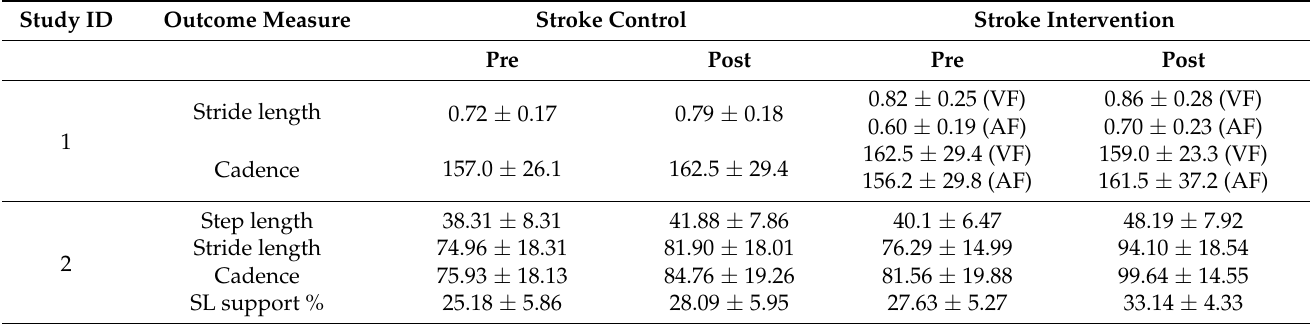
Table A1. Treadmill Intervention Outcome